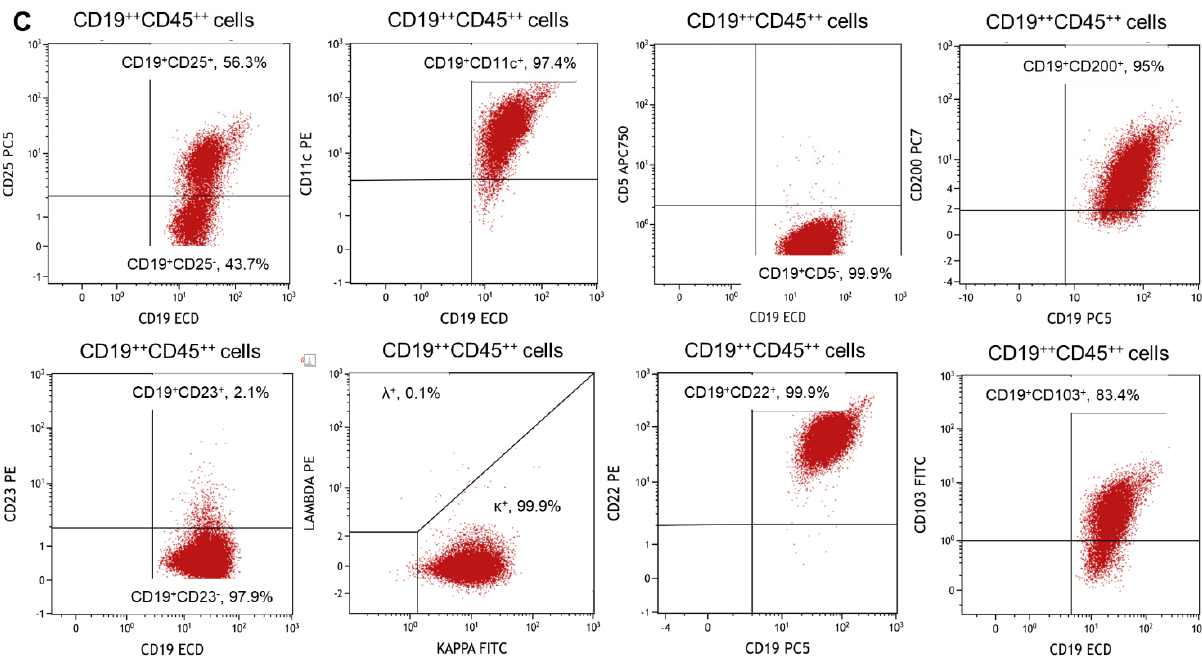
Figure 2. Flow cytometry characterization of chronic lymphocytic leukemia (CLL) and hairy cell leukemia (HCL) clones. ( A ) CLL clone after five years from diagnosis showing positivity for CD19, CD5, CD23, and SmIg κ . ( B ) Minimal residual disease of CLL clone at Richter’s disease diagnosis displaying a small CLL population positive for CD19, CD5, CD23, and SmIg κ . ( C ) HCL clone with negativity for CD10, CD5, CD23, CD43, and CD38, and positivity for CD20, CD22, FMC7, CD103, CD11c, CD25, CD49d, CD200, and SmIg κ .